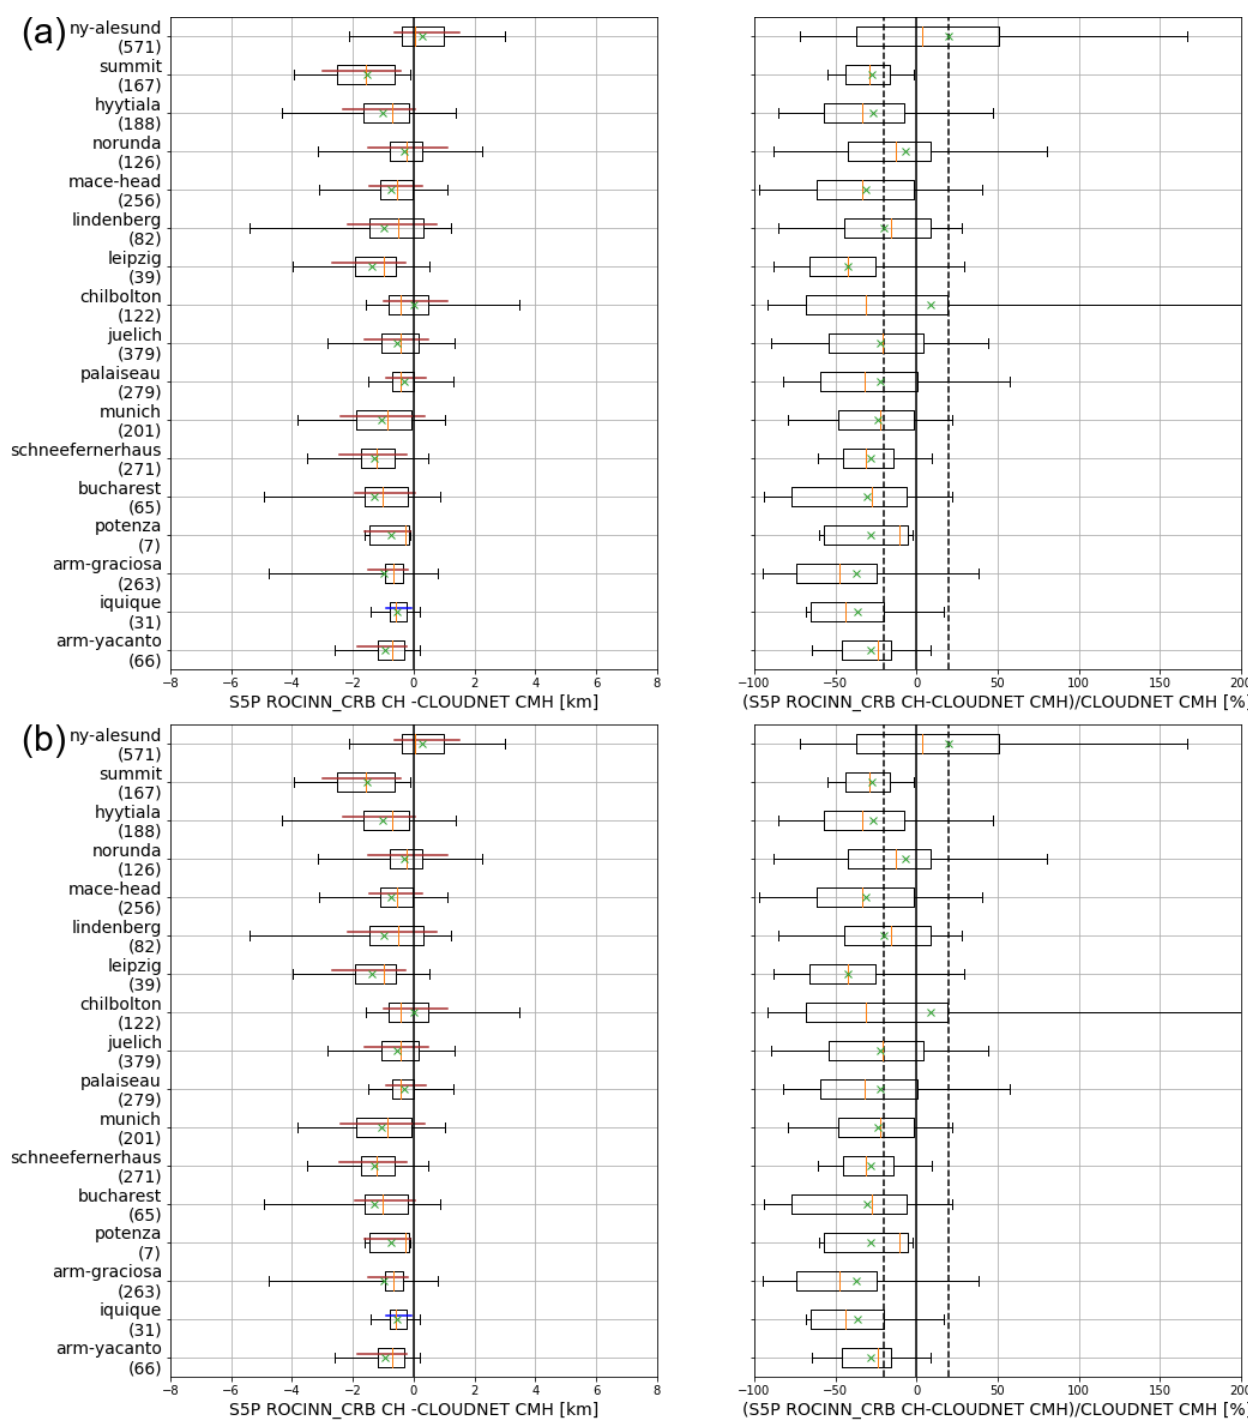
Figure 12. Panel (a) shows boxplots of the difference (left) and relative difference (right) between S5P OCRA/ROCINN_CRB CH and Cloudnet CMH. Similar for panel (b) but between S5P FRESCO CH and Cloudnet CMH. The same conventions as in Fig. 11 are